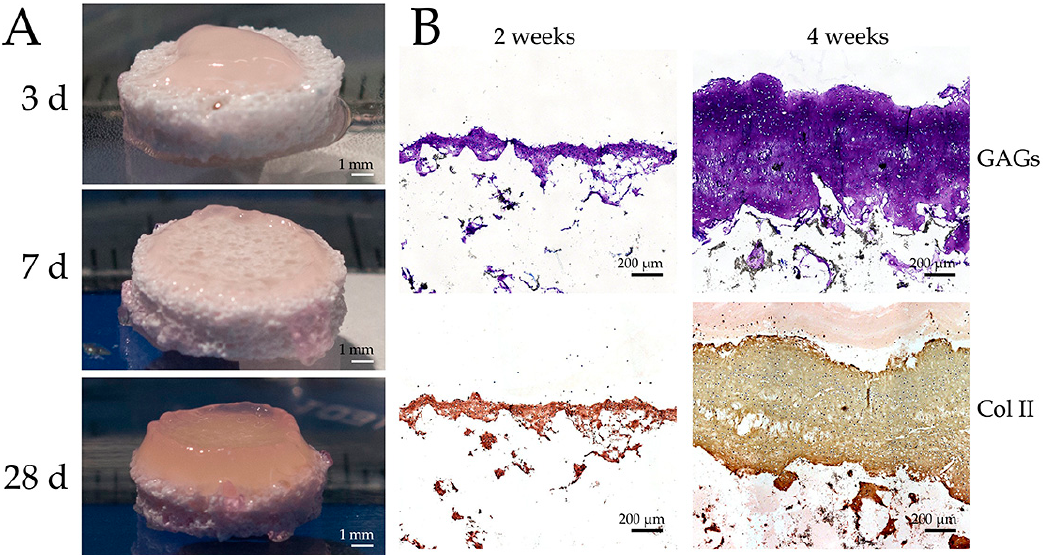
Figure 3. ( A ) An example of bovine articular chondrocytes (six million cells) grown inside agarose wells on top of Scaffdex Cellceram™ insert scaffold composites consisting of hydroxyapatite (60%) and β -tricalciumphosphate (40%), and cultured for three, seven, and 28 days. ( B ) The histological sections of chondrocyte/Cellceram™ inserts stained with Toluidine blue for glycosamionoglycans (GAGs) (blue color in upper images) and immunostained for the type II collagen (Col II, brownish color in lower images) after two and four weeks culture period.